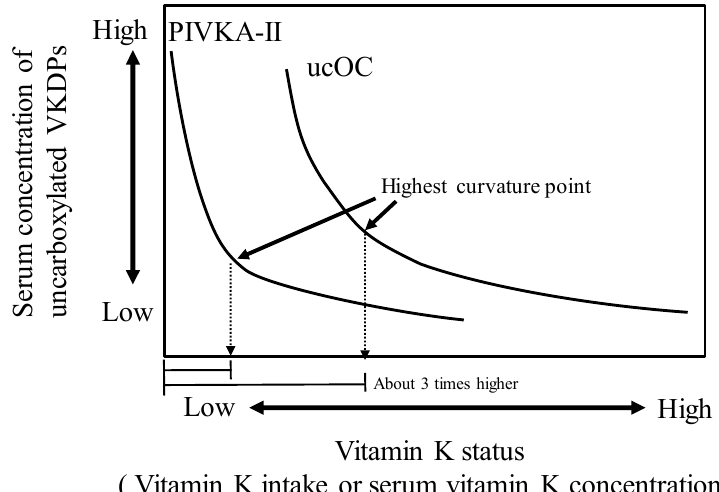
Figure 3. Relationship between vitamin K nutritional status and uncarboxylated vitamin K-dependent proteins (VKDPs) as a vitamin K deficiency marker in adolescents (adapted from reference [29]). Abbreviations: PIVKA-II, protein induced by vitamin K absence or antagonist-II; ucOC, uncarboxylated osteocalcin.